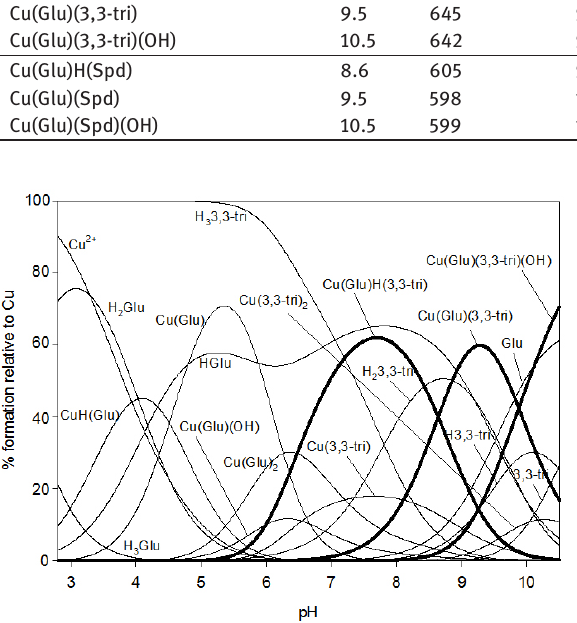
Figure 3 : Distribution diagram for the Cu(II)/Glu/3,3- tri system; percentage of the species refers to total metal; C C =1×10 -3 M; C =1×10 -3 M, at 20 o C, µ=0.1 mol L -1 (KNO Glu 3,3- tri